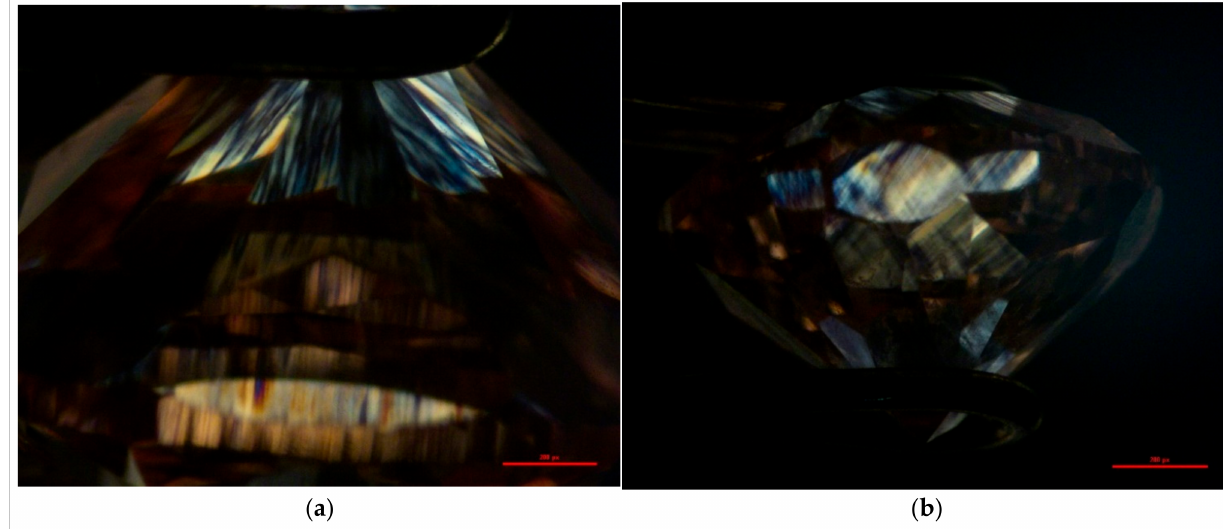
Figure 3. Strong birefringence is displayed in the ZX04 sample when observed with crossed polarisers. ( a ) Linear pattern magnified 16 × . ( b ) Grid-like pattern magnified 10 × . Photomicrograph by Z. Song.